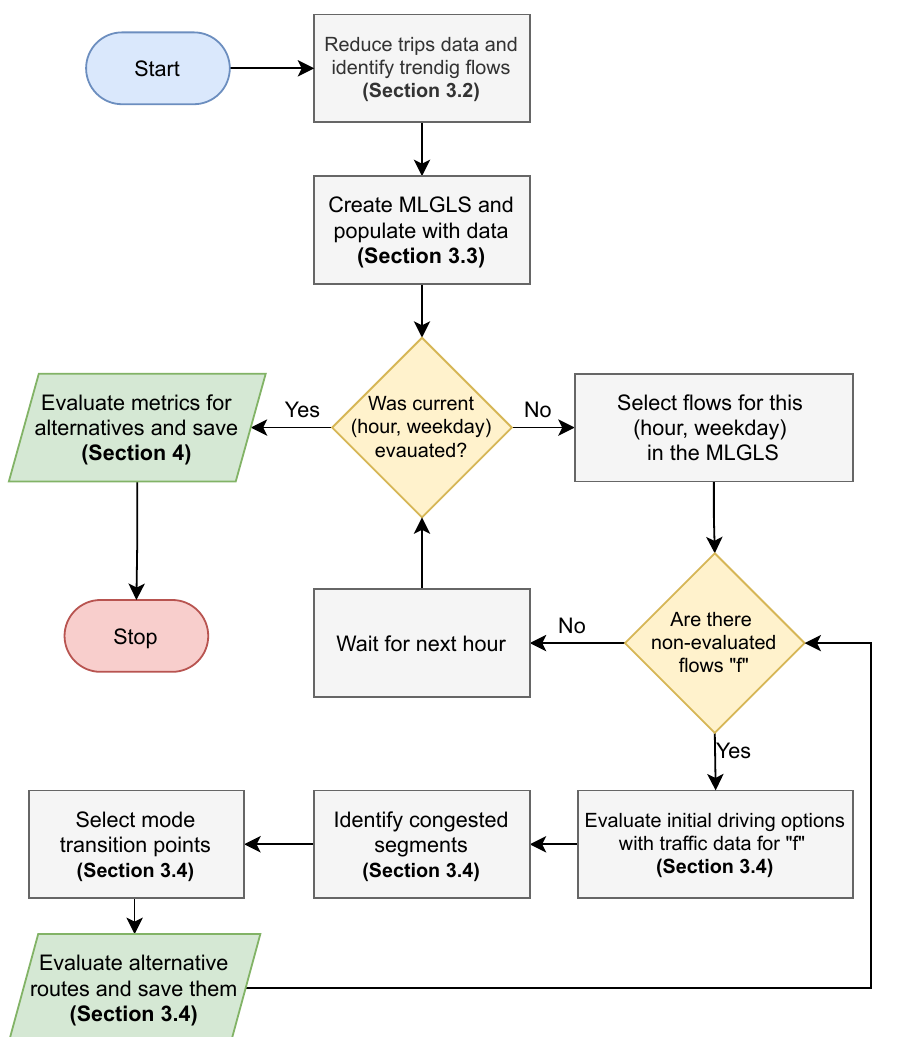
Figure 2. Work flow to evaluate the impact of using hybrid-multimodal routes to replace taxi trips in New